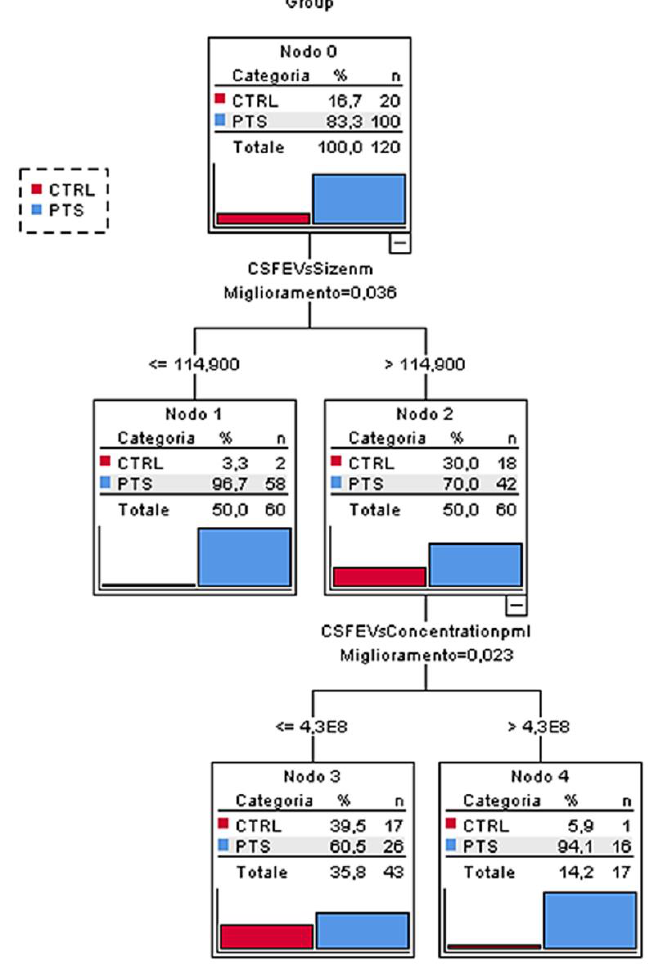
Figure 3. Classification tree. EV size resulted in being the most predictive variable among all the ones significantly associated to the groups. CTRL, controls; PTS, patients; CSFEVs size (nm), EV size (nm); CSFEVs concentration (p/mL), EV concentration (EVs/mL).